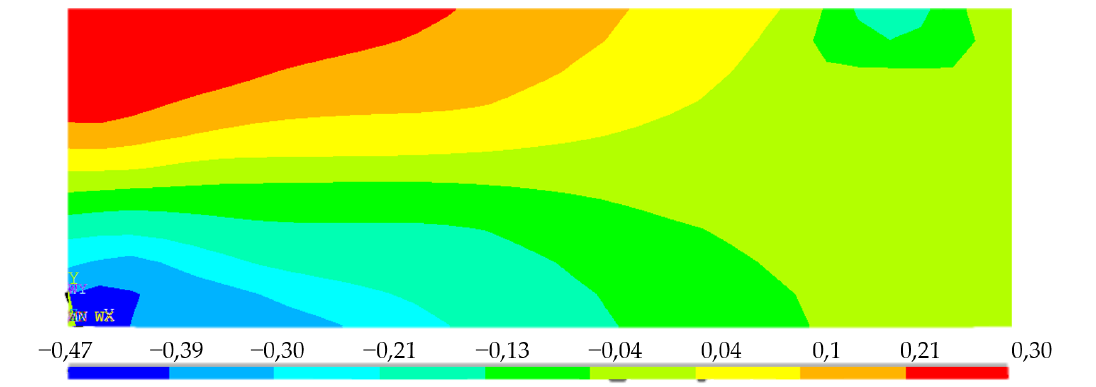
Figure 22. Example of FEM results–main normal stress σ 1 redistribution–longitudinal-section, load F = 280 N.